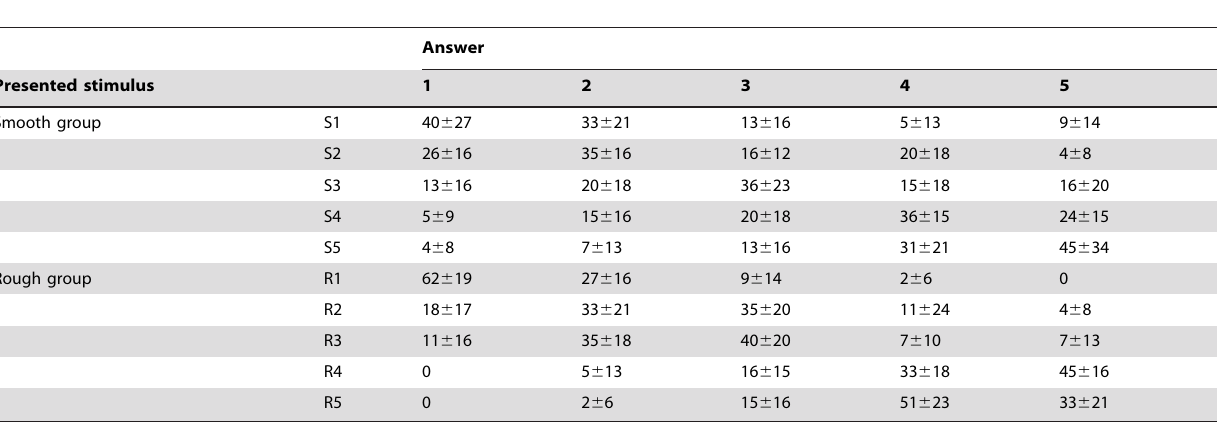
Table 2. Average of the answer counts in percent 6 standard deviation for each stimulus in the identification task.